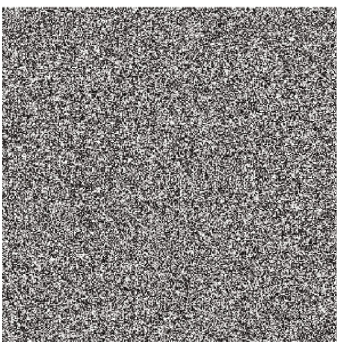
Figure 7: Decryption diagram of wrong key.